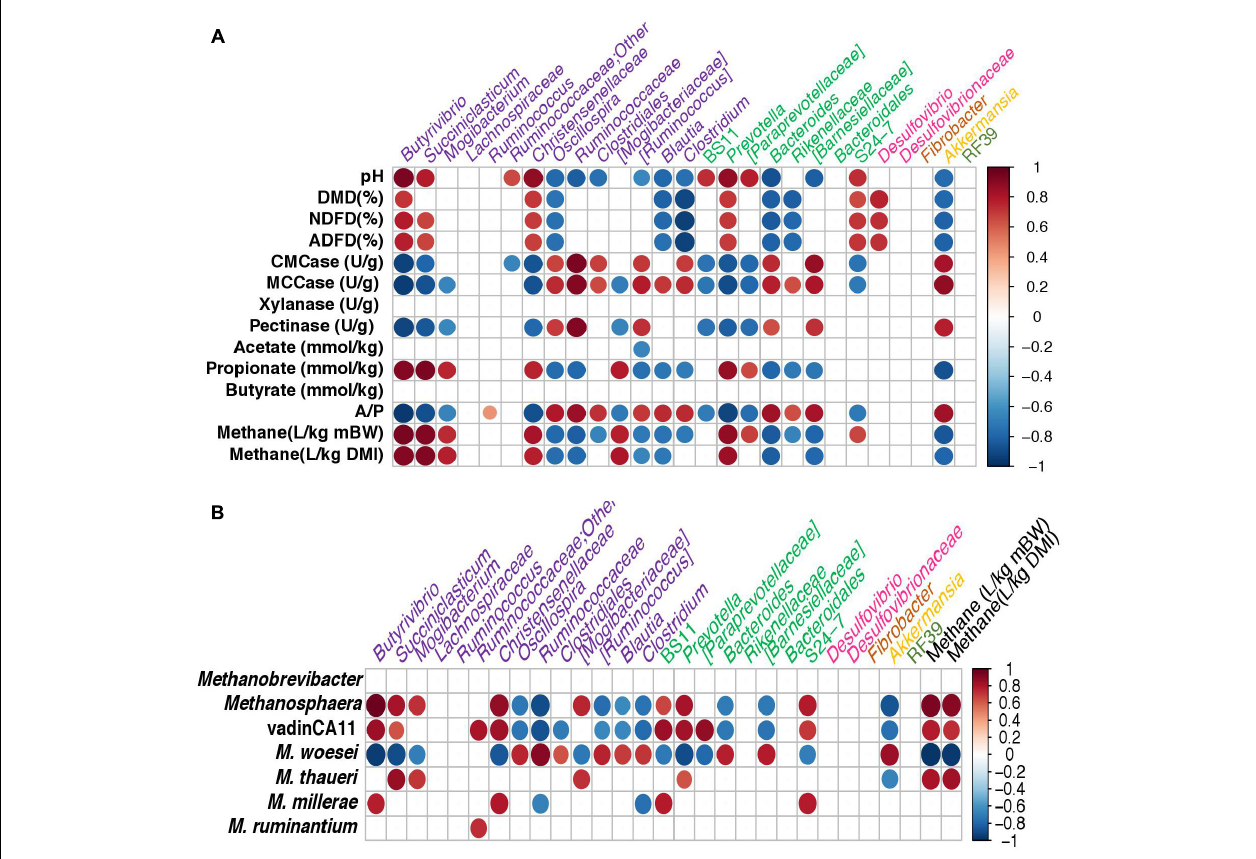
FIGURE 6 | Pearson correlation between (A) chemical parameters and the relative abundance of bacterial taxa; (B) Archaeal taxa and bacterial taxa in relative abundance for the sheep rumen ( n = 5) and the rabbit cecum ( n = 5 blocks) in combination. Taxa were included in the matrix only if they were found in at least 3 of the five sheep or five rabbit blocks and they were each represented by at least 1.0% of the total bacterial sequences. Size of the filled circle reflects the strength of the correlations. Only significant correlation ( P < 0.05) were shown with colors. The scale colors denote the direction of correlation (1 to –1). The taxa assigned to different phyla were color coded: purple, Firmicutes; green, Bacteroidetes; pink, Proteobacteria; brown, Fibrobacteres; yellow, Verrucomicrobia; and olive , Tenericutes .